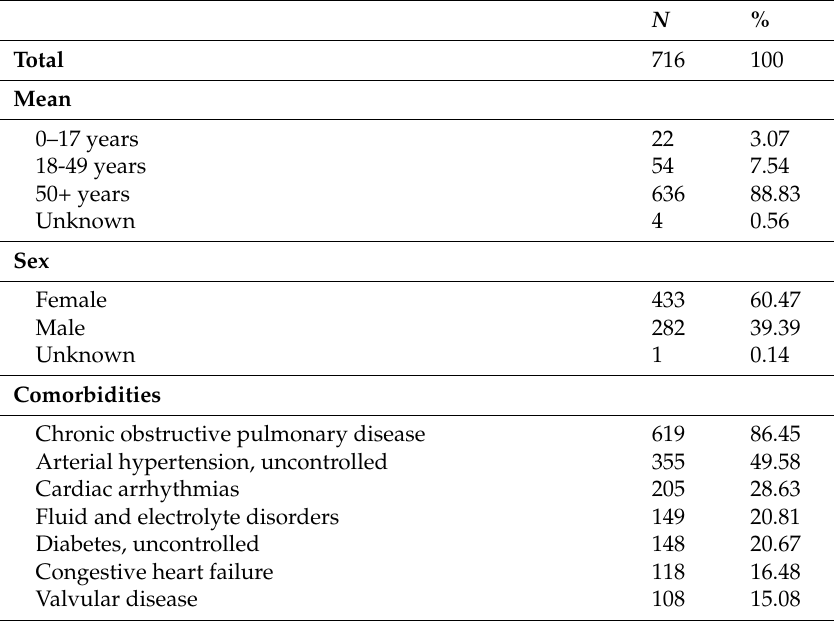
Table 1. Demographics and clinical characteristics of Non-Cystic Fibrosis Bronchiectasis (NCFBE) patients with P. aeruginosa